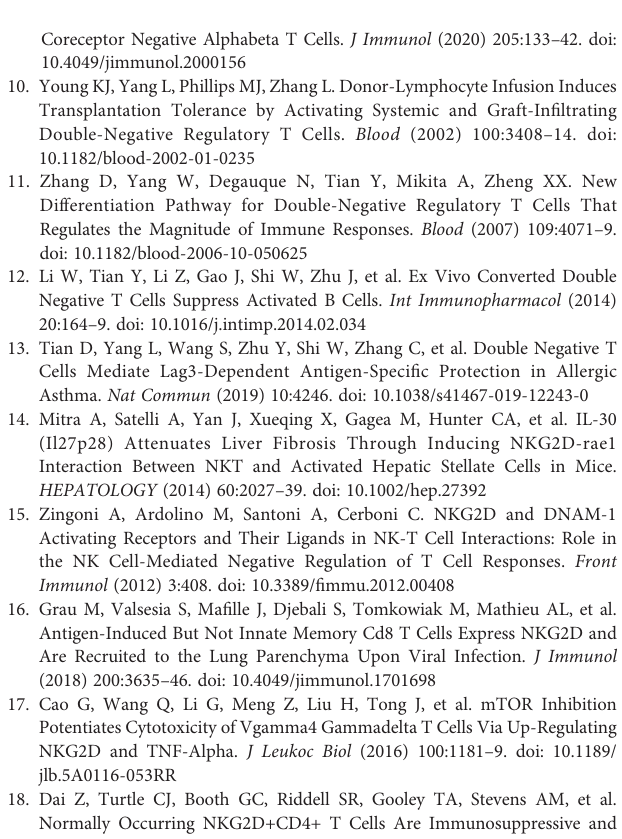
Supplementary Figure 1 | The mRNA and Protein expression of Rae1 and Mult1. (A – E) Naïve B cells werestimulated with LPS(10 m g/mL) in B cellmedium for 0, 6, 18 and 48 hours. Flow cytometry was performed to examine the expression of Rae1 and Mult1. (A) The protein expression of Rae1 was upregulated with the extension of culture time. (B) Geometric MFI of Rae1. (C) Percent of Rae1 protein expression with culture time. (D) The protein expression of Mult1. (E) Geometric MFI of Mult1. Figures 1A – E is an independent experiment. Student ’ s t-test was used to compare two independent variables (ns, not signi fi cant, *p < 0.05, **p < 0.01, and ***p <